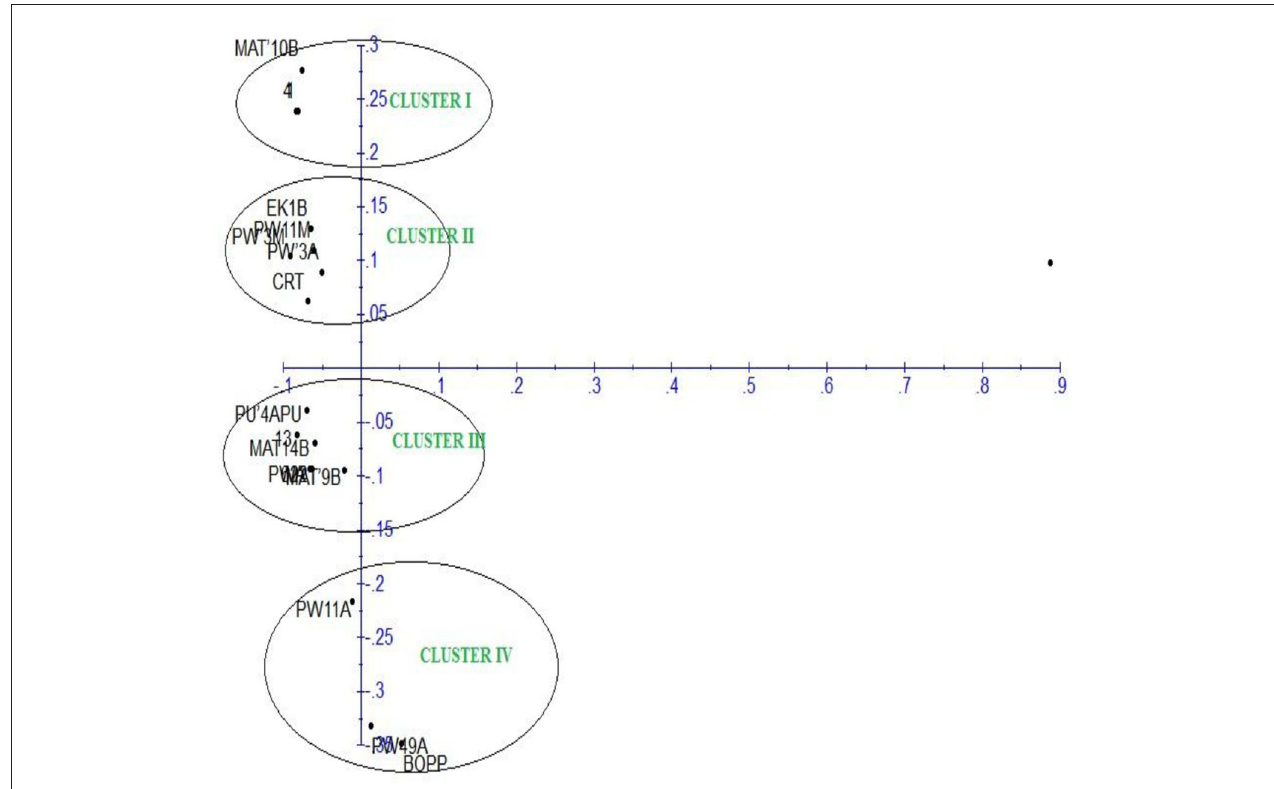
FIGURE 6 | Principal component analysis of F. oxysporum f.sp. elaeidis strains based on Inter-simple sequence repeat markers.